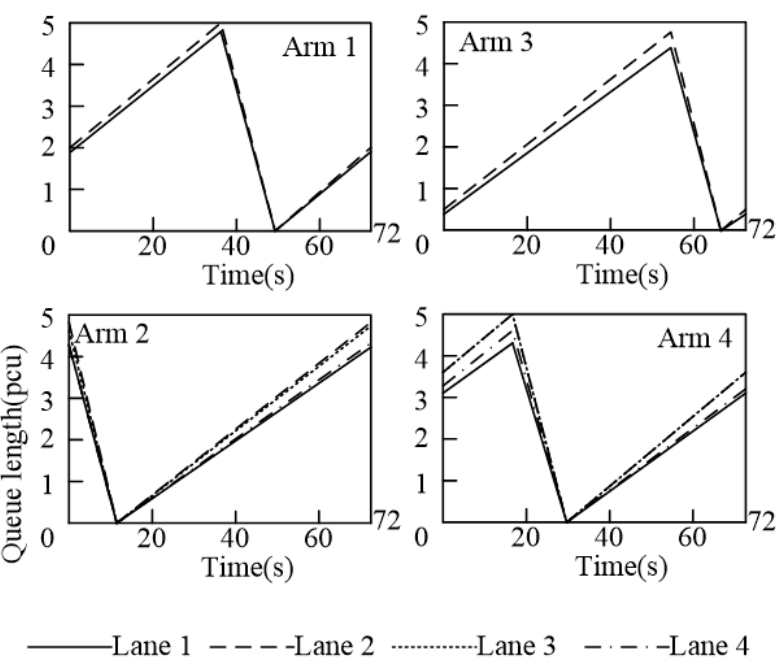
Figure 7. Queue length (in pcu) against time (from start to end of a signal cycle in seconds) from the optimized traffic signal settings in morning-peak period.